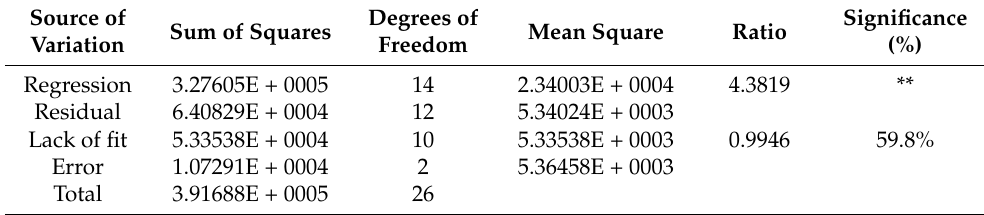
Table 7. Analysis of variance for biomass production